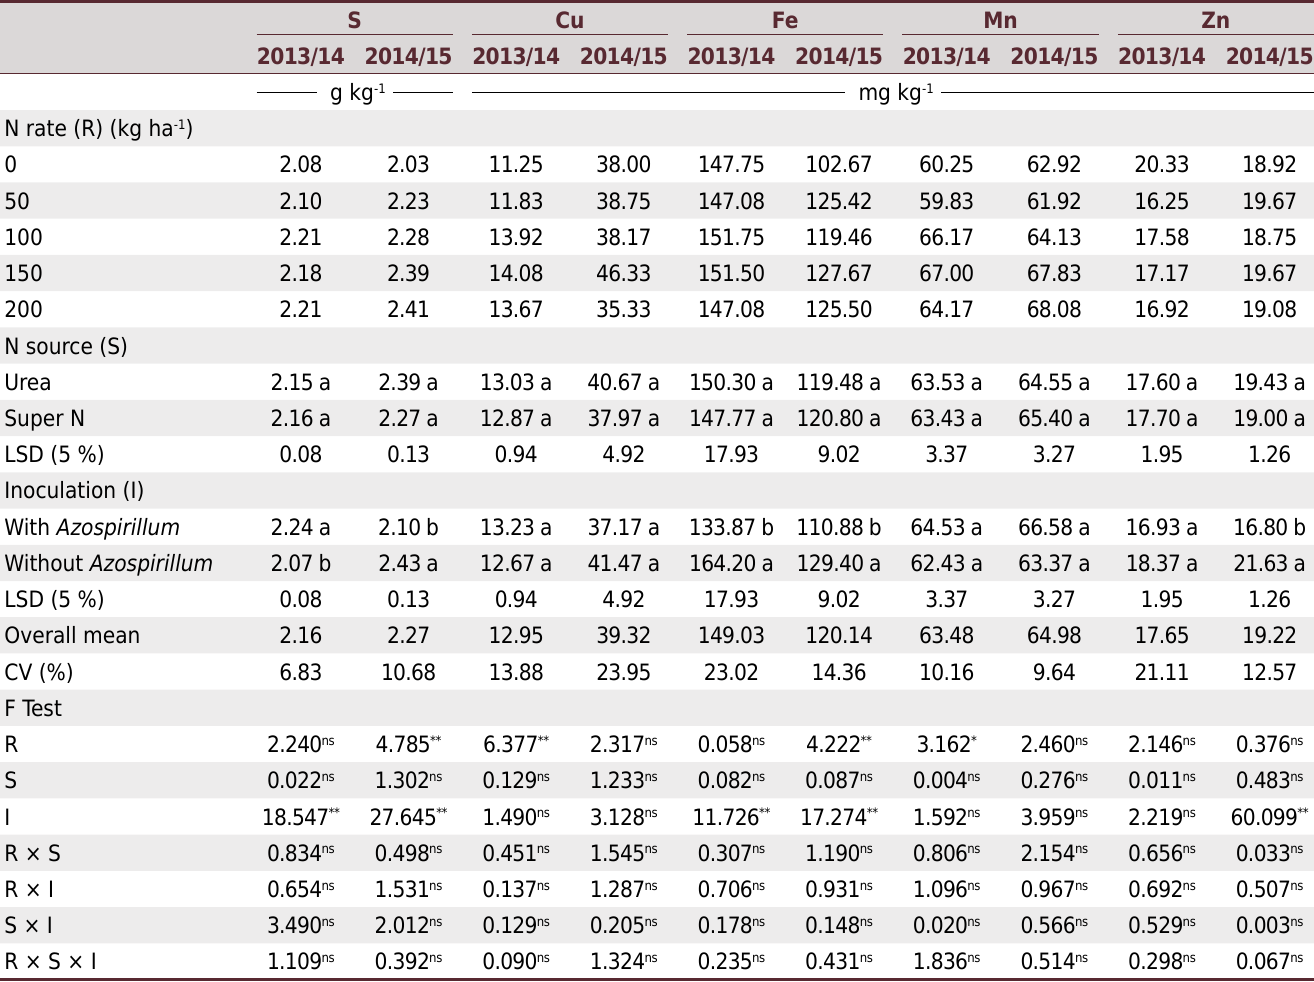
Table 2. Means and Tukey test concerning sulfur, cooper, iron, manganese, and zinc leaf concentrations of corn affected by of rates and sources of nitrogen, with or without inoculation with Azospirillum brasilense (2013/14 and 2014/15) S Cu Fe Mn